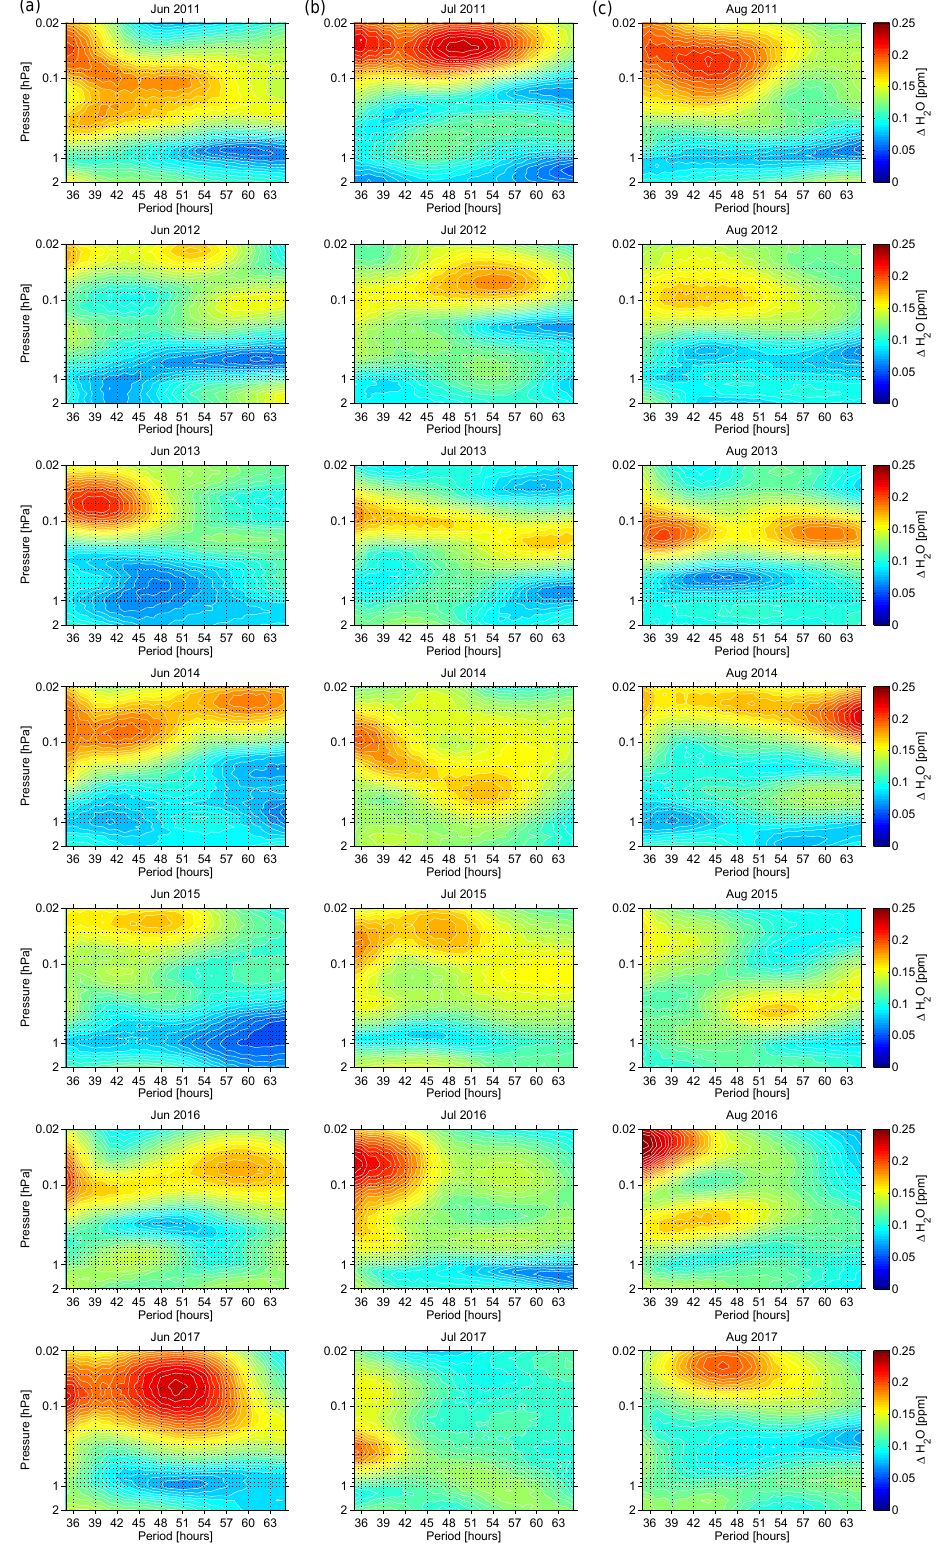
Figure 3. Monthly averaged water vapor wave amplitude spectra with periods between 35 and 65h in units of ppm. Presented are the months June (a) , July (b) and August (c) for the years from 2011 to